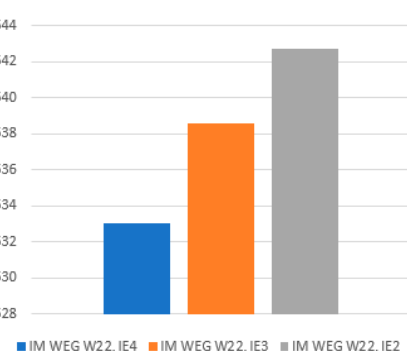
Figure 4. Annual energy consumption E y.m (MW · h).